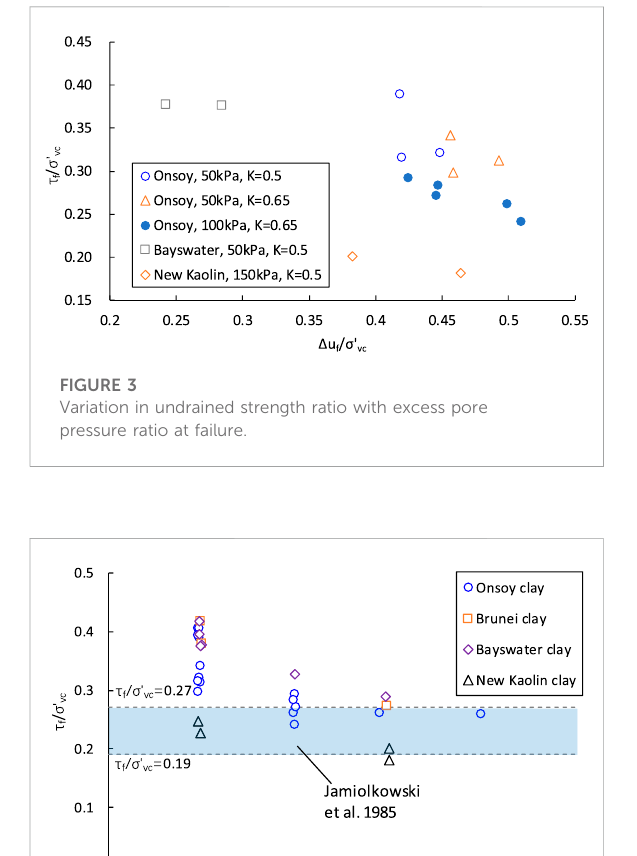
FIGURE 7 Variation in excess pore pressure ratio at failure with shearing